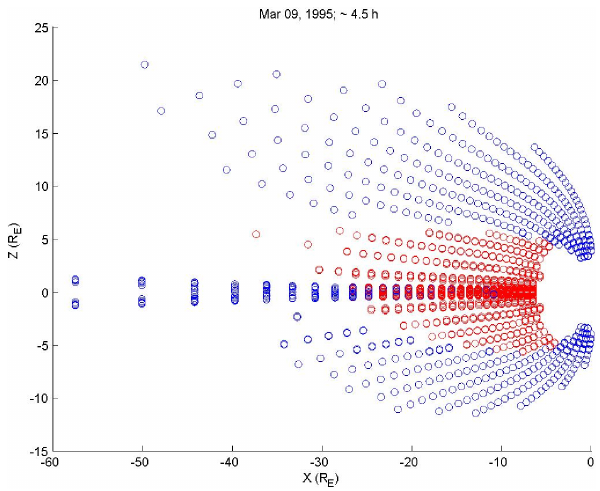
Fig. 1. Plasma sheet (red circles) and the lobes (blue circles) in the XZ-plane from the simulated substorm of 9 March